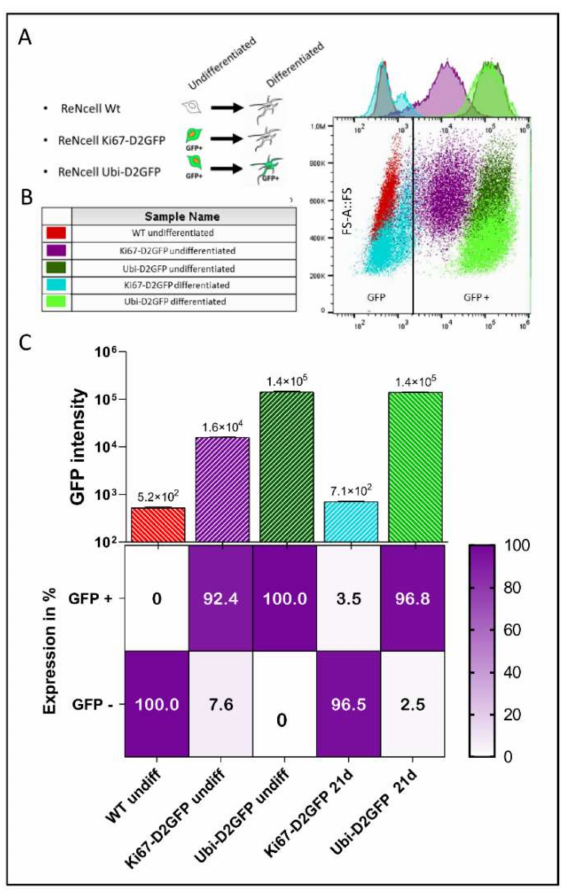
Figure 3. Reporter gene expression: Ki67 versus ubiquitin promoter. D2GFP was expressed in ReNcells (immortalized neural precursor cells) under the control of the two different promoters. Wild type ReNcells were used as control. ( A ) Schematic representation of the expected reporter gene (D2GFP) expression driven by the cell cycle-dependent Ki67 or the ubiquitous ubiquitin promoters, ( B ) Scatter plots and representative histograms from FACS showing D2GFP intensity on the x- axis, and forward scatter (FS) on the y-axis. Data shown are representative of three independent experiments. ( C ) Average of GFP intensity measured by FACS analysis ( n = 3); all data are represented as the mean ± SD, and corresponding percentage of GFP positive and negative